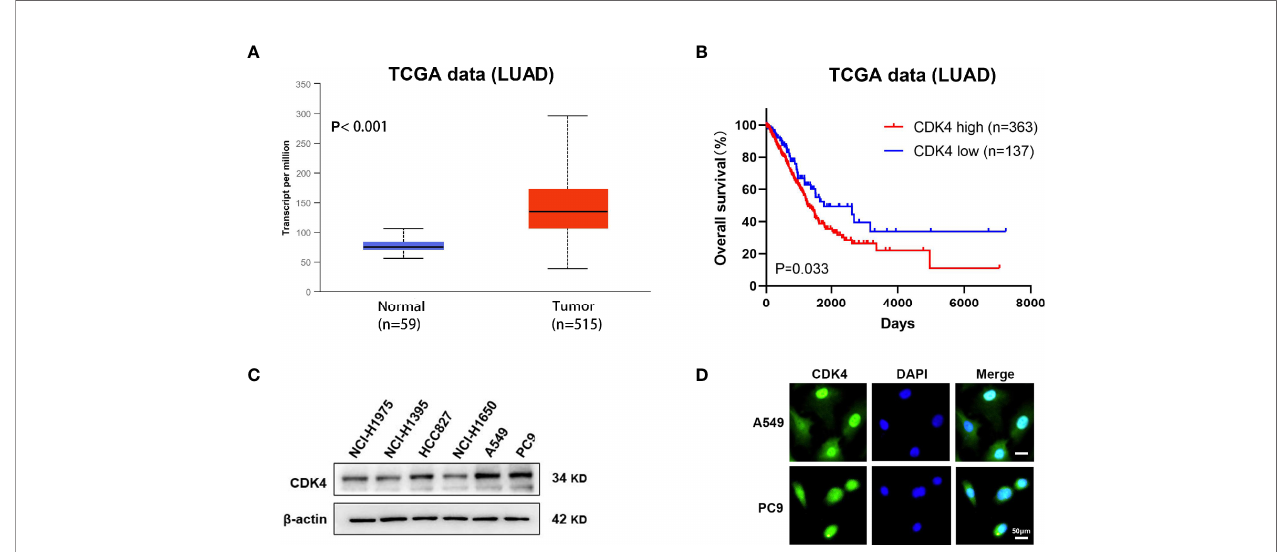
FIGURE 1 | Elevated expression of CDK4 indicates a poor prognosis in patients with LUAD. (A) Representative data extracted from TCGA datasets showing the relative expression of CDK4 mRNA in LUAD tissues compared with normal tissues. (B) Kaplan – Meier analysis showing the correlation between CDK4 mRNA expression and OS for the patients with LUAD included in TCGA datasets. (C) Western blotting analysis was performed using different LUAD cells. (D) IF staining for CDK4 in A549 and PC9 cell lines. The scale bars represent 50 m m. LUAD, lung adenocarcinoma; TCGA, The Cancer Genome Atlas; OS, overall survival; IF, immuno fl uorescence.